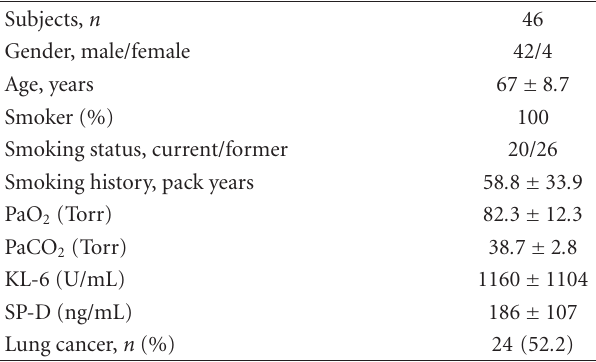
Table 1: Clinical characteristics at diagnosis in CPFE